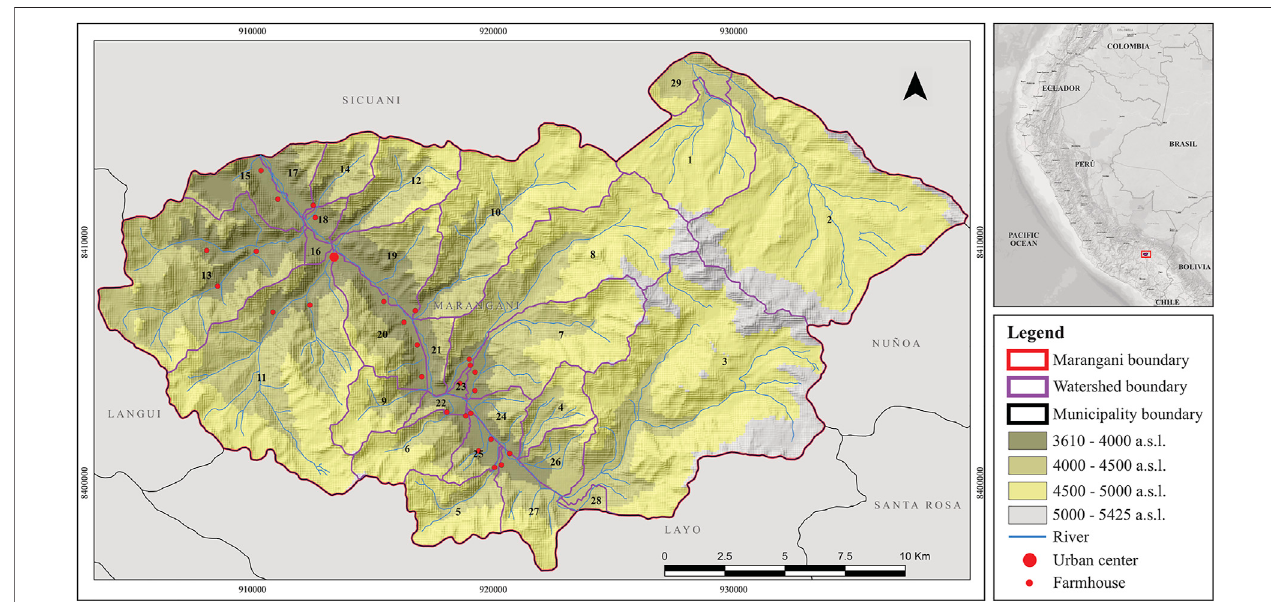
FIGURE1| Studyareawithelevationandwatersheddistribution(left),PeruwithESRI ′ Standardmap(topright).Watersheds:1.Tañihuastream;2.Aucarariver;3. Cantacantariver;4.Chuabambastream;5.Tadiohuaycostream; 6.Llallahuistream;7.Quiscamayostream;8.Quecjrariver;9.Lorocachistream;10.Cuyostream;11. Casuirariver;12.Caycostream;13.Comayacustream;14.Ccatunhuasistream;15.Intercuenca1;16.Inter-watershed2;17.Inter-watershed3;18.Inter-watershed4; 19.Inter-watershed5;20.Inter-watershed6;21.Inter-watershed 7;22.Inter-watershed 8;23.Inter-watershed9;24.Inter-watershed10;25.Inter-watershed 11;